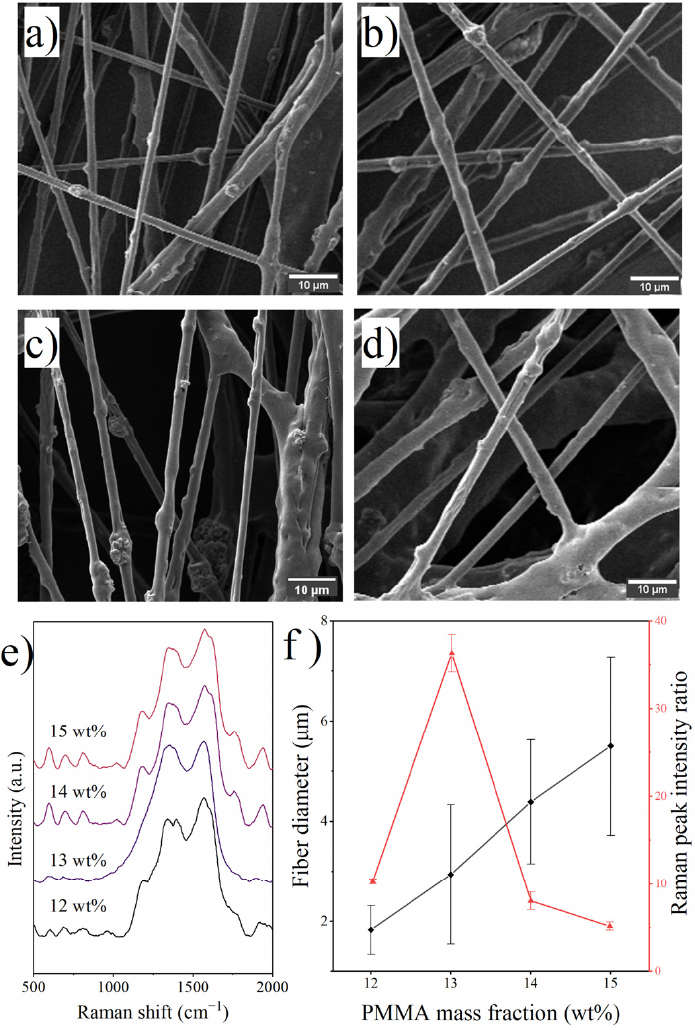
Figure 2. SEM images of fibers prepared with various PMMA mass fractions: ( a ) 12 wt%, ( b ) 13 wt%, ( c ) 14 wt%, ( d ) 15 wt%; ( e ) Raman spectra of the fibers and ( f ) effects of PMMA mass fraction on fiber diameter and surface PANI occupancy.